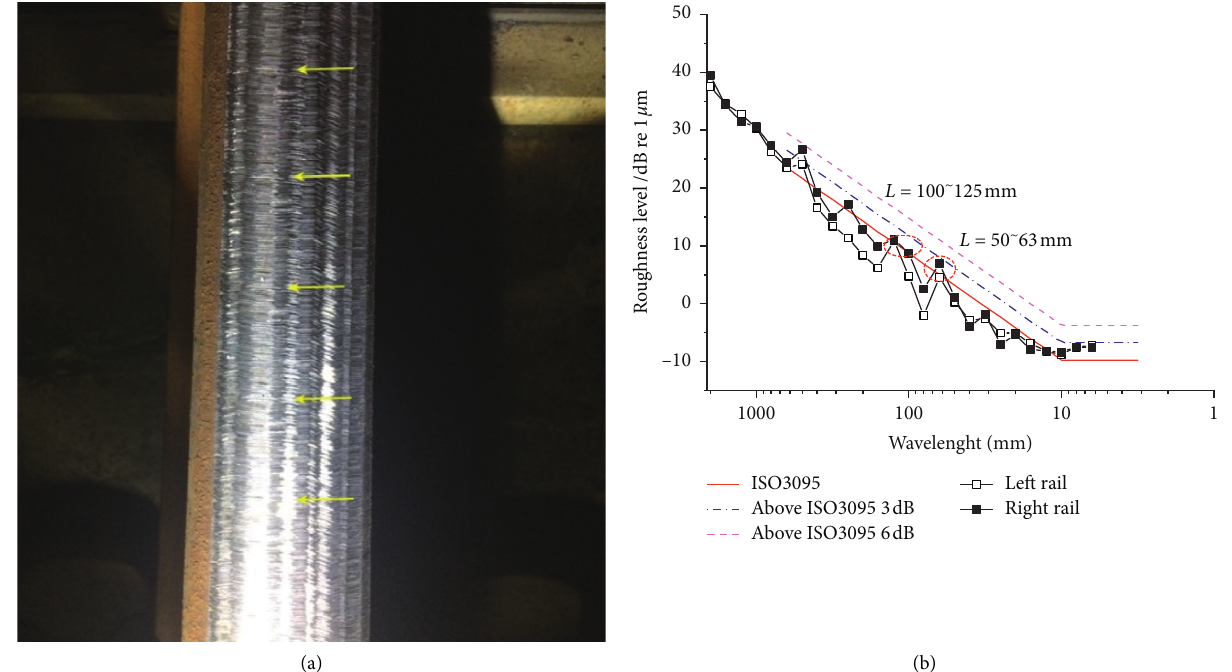
Figure 3: Picture and roughness spectra of rail corrugation in Section C.